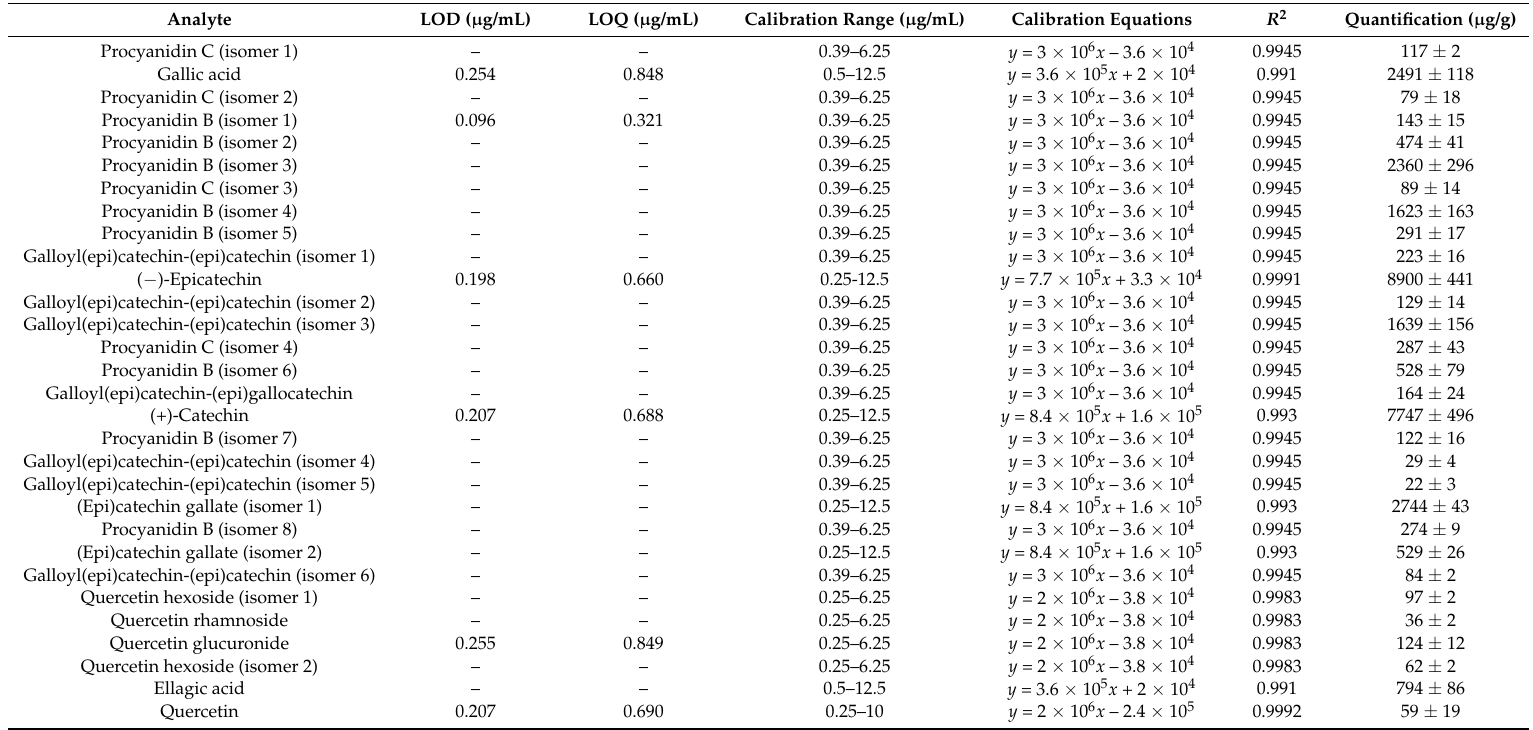
Table 2. Quantification data of compounds from grape seed extract: limit of detection (LOD) and quantification (LOQ), calibration range used for each calibration curve, linear equations and the coefficient of variation (R 2 ). LOD and LOQ values were calculated for the available standards solely. Quantitation values are expressed as mean ± standard deviation (in µ g of analyte per gram of dry